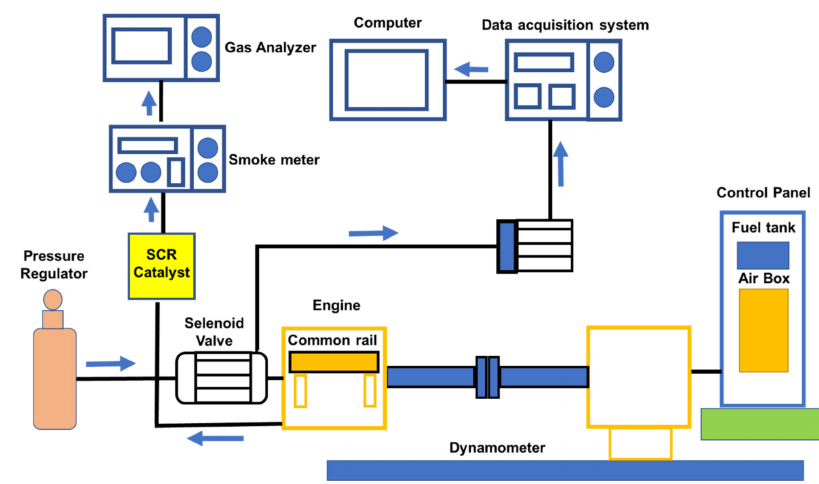
Figure 2. The schematic diagram for the 1000 cc diesel engine on test [54].